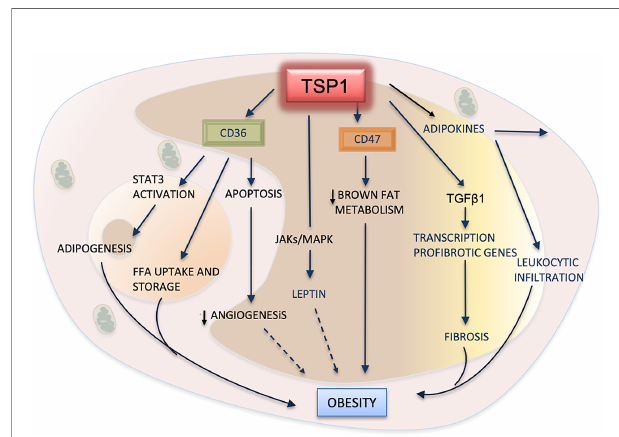
FIGURE 4 | TSP1 in adipose metabolism and obesity. TSP1 activates the latent form of transforming growth factor beta1 (TGF b 1), consequently promoting the recruitment of leukocytes, the in fl ux of macrophages to the adipose tissue, and the release of in fl ammatory cytokines and adipokines. TGF b 1 will also contribute to fi brosis of adipose tissues by inducing the transcription of pro- fi brotic genes. By interacting with TSP1, CD47 suppresses the mitochondrial metabolism in brown adipose cells, therefore exhibiting a pro-obesity effect. TSP1 interacts with the hormone leptin by activating the JAK/STATs pathway. Increased plasma levels of leptin are correlated with high body fatness. The dashed arrow indicates a probable but yet unexplained association with obesity. CD36 facilitates the uptake of free fatty acids (FFA) into adipose cells, but it can also promote the apoptosis of endothelial cells, decreasing angiogenesis. Perhaps, this could contribute to the lower vascularization observed in white adipose tissues during the progression of this condition (dashed arrow). Finally, CD36 can regulate adipogenesis and expansion of adipose cells by activating the signal transducer and activator of transcription 3 (STAT3)